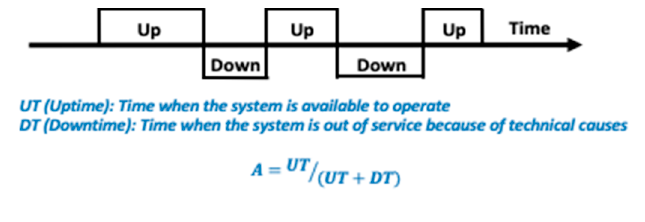
Figure 3. Availability computation.